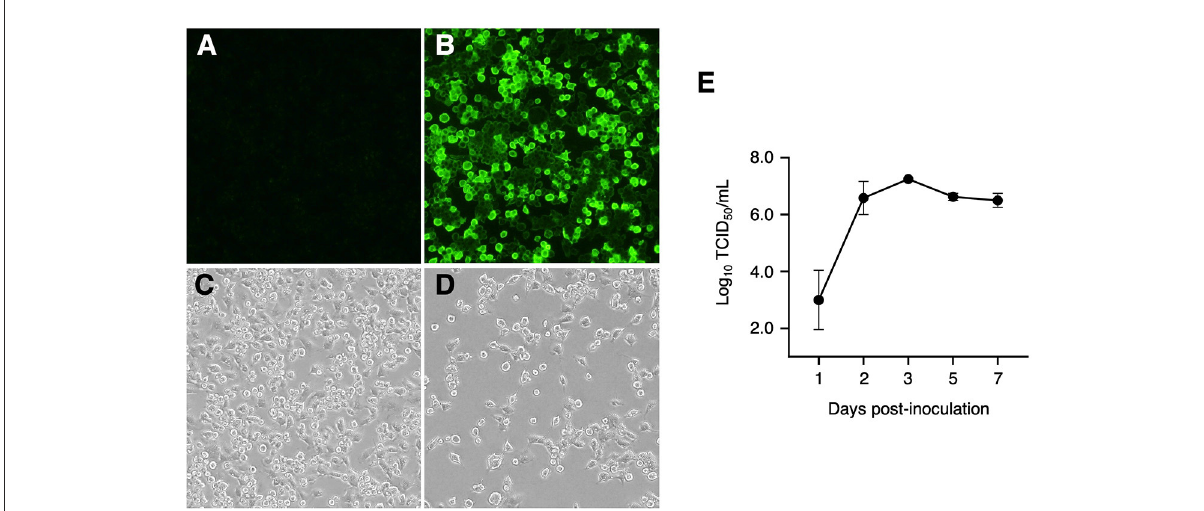
FIGURE7 Detection of PRRSV antigens using an immunofluorescence assay, cytopathic effects, and viral growth curve for PRRSV-inoculated IPIM. A direct immunofluorescence assay was performed with FITC-conjugated anti-PRRSV monoclonal antibodies using mock-inoculated (A) and PRRSV-inoculated (B) cells at 3 dpi. The cytopathic effects of the PRRSV were also evaluated in mock-inoculated (C) and PRRSV-inoculated (D) cells at 7 dpi under a phase-contrast microscope. After inoculation with PRRSV, culture supernatant samples were collected at the indicated timepoints and used for titration experiments with the IPIM (E) . Data are expressed as the mean ± SEM of three experiments (E)